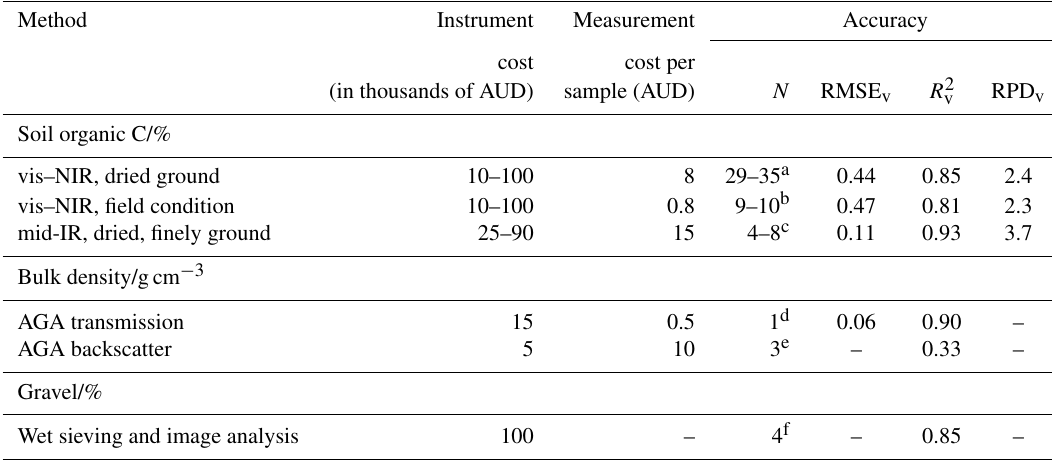
Table 4. Assessment of the accuracy and cost of sensing technologies for soil C accounting. The methods are visible–near infrared (vis–NIR) and mid-infrared (mid-IR) diffuse reflectance spectroscopy; active gamma-ray attenuation (AGA) and wet sieving and image analysis. The accuracy at local scale (i) for soil organic C concentrations is based on comparison with dry-combustion analysis on the same samples and represented by median values for dry soil samples (vis–NIR and mid-IR) and wet samples (vis–NIR only); (ii) for bulk density is based on a comparison with the volumetric ring method and represented by median values for wet soil corrected for water with vis–NIR measurements on the same samples (transmission) or for wet soil corrected for gravimetric water content on paired samples (backscatter); and (iii) for gravel content is based on a comparison of image analysis with weighing on the same wet-sieved samples and represented by median values. The statistics reported are the root mean square error of validation (RMSE v ), the coefficient of determination ( R 2 v ), and the ratio of performance to deviation (RPD v ). N are the number of local sites at which accuracy was